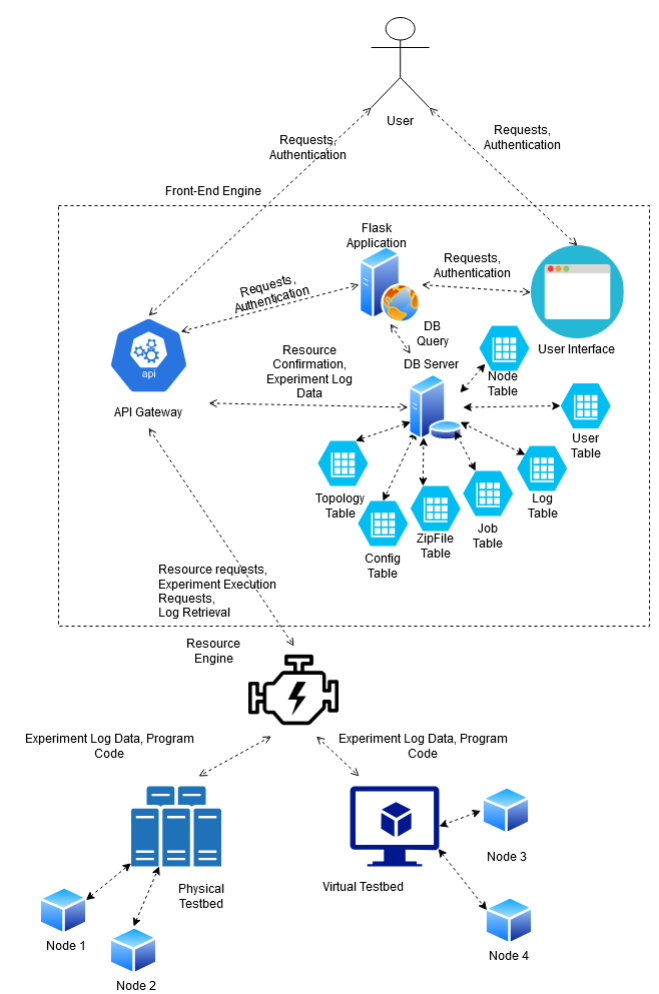
Figure 5. System Architecture of the IoT Cyber